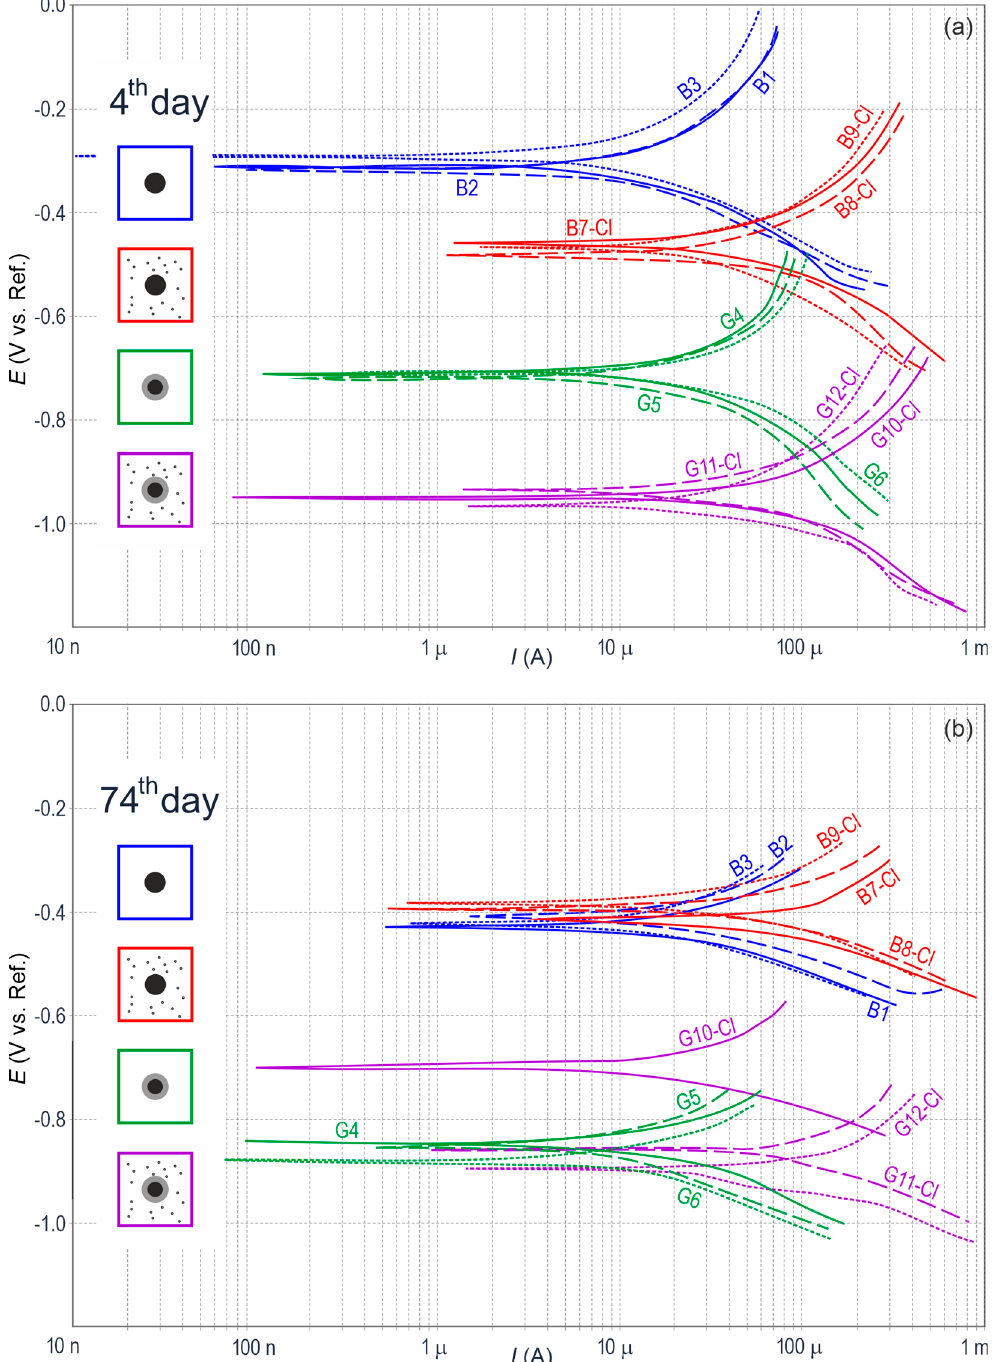
Figure 4. Potentiodynamic polarization curves for steel reinforcement in concrete from 12 specimens ( a ) on day 4 and ( b ) on day 74 of measurements: B —black steel in concrete without additives, G —galvanized steel in concrete without additives, B-Cl —black steel in concrete with chlorides, and G-Cl —galvanized steel in concrete with chlorides.